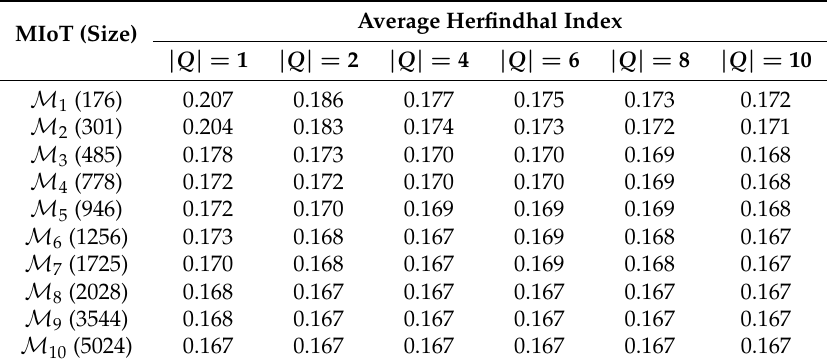
Table 8. Average Herfindahl Index of virtual IoTs against the size of MIoTs and queries used to generate the virtual IoTs (supervised approach).